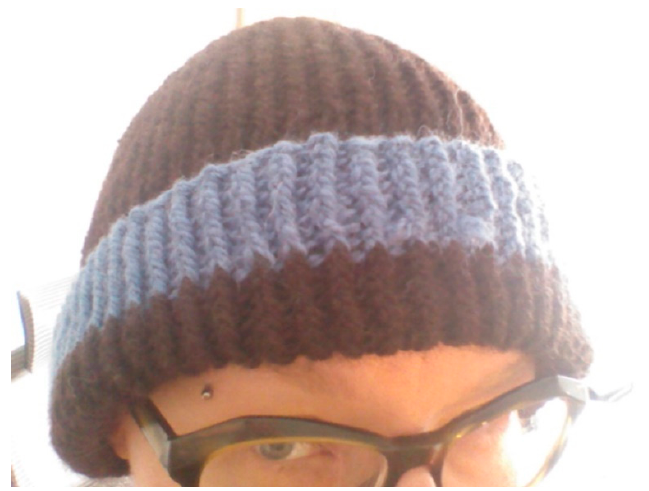
Figure 10. A körttipipa . Photograph: author.